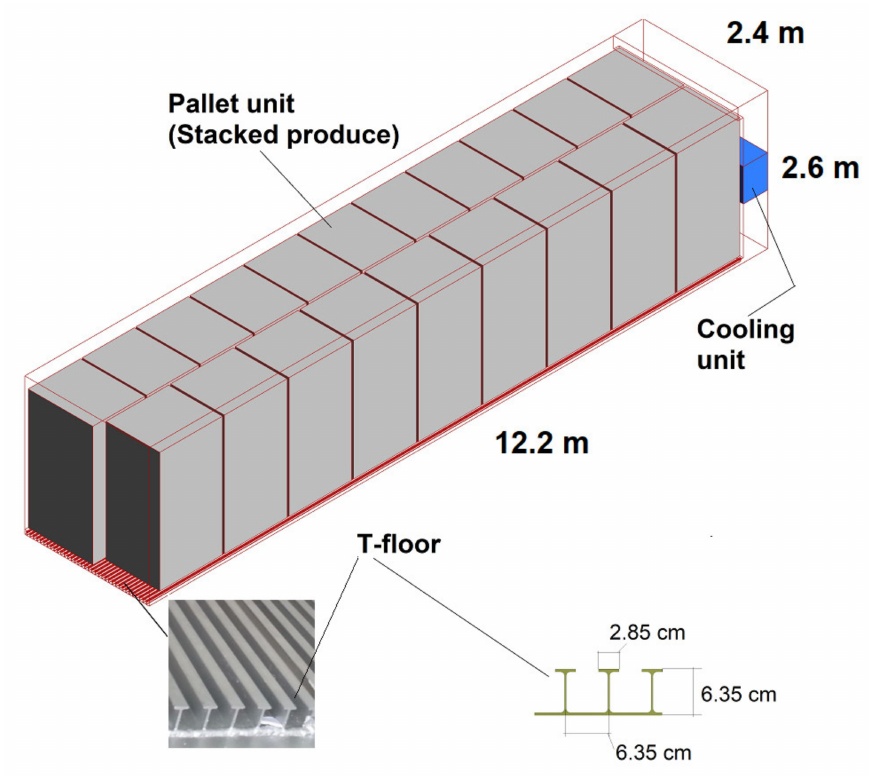
Figure 5. Schematic depiction of bottom-air-delivery T-bar reefer and a closer view of the T-bar floor